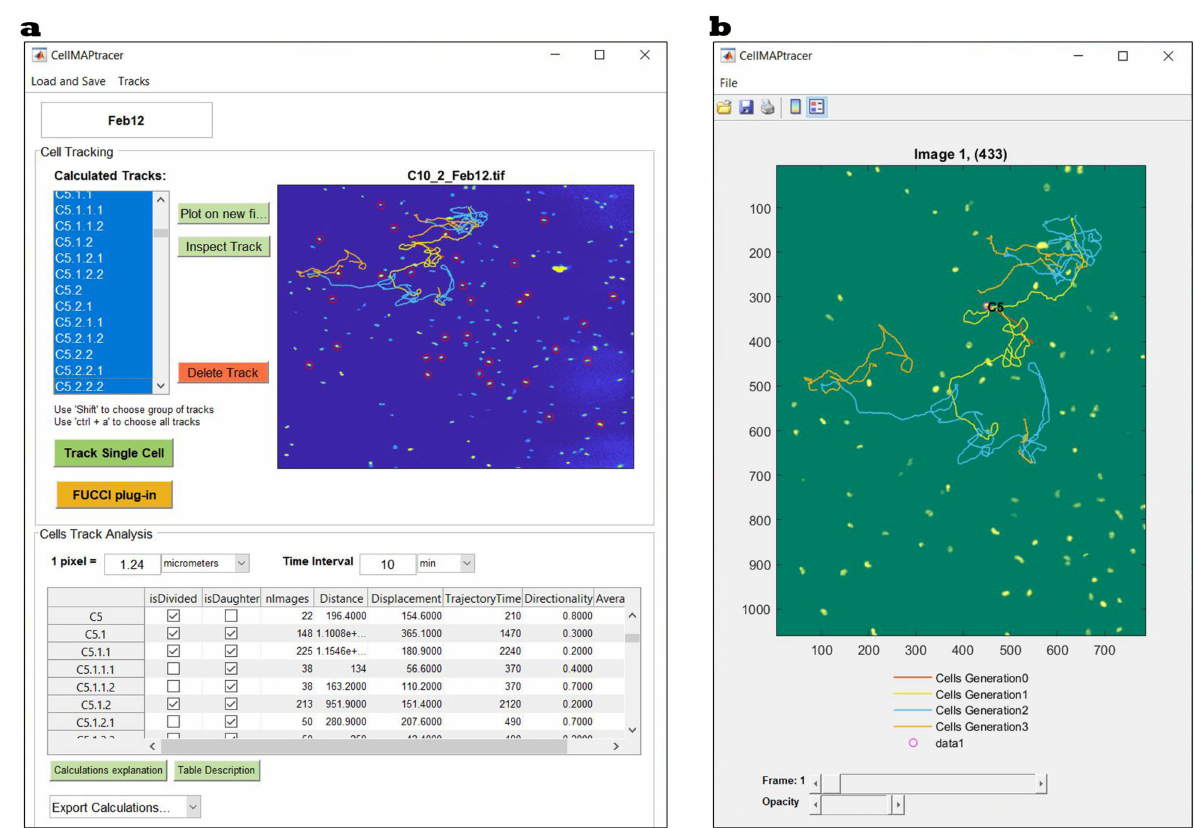
Figure 1. CellMAPtracer graphical user interface. ( a ) The main user interface window used to track single cells and all their descendant cells. ( b ) A representative interactive multigeneration trajectory plot of a cell (orange) and its descendant daughters (yellow) and granddaughters